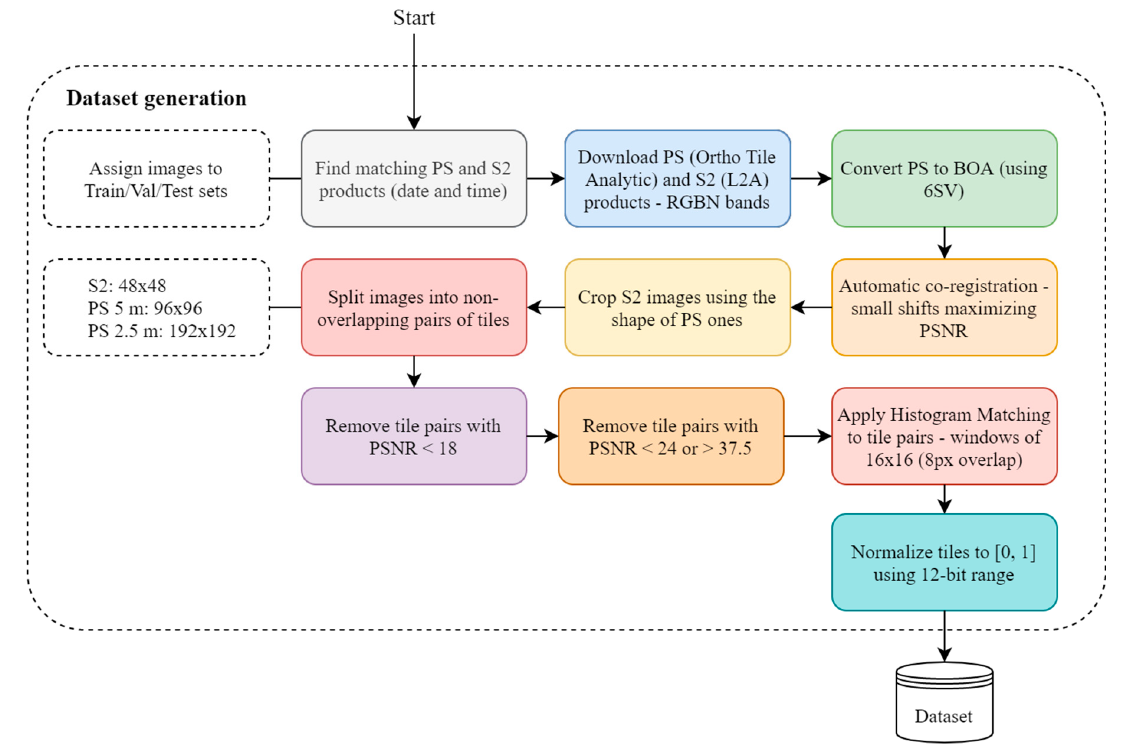
Figure 8. Diagram summarizing the steps for the dataset